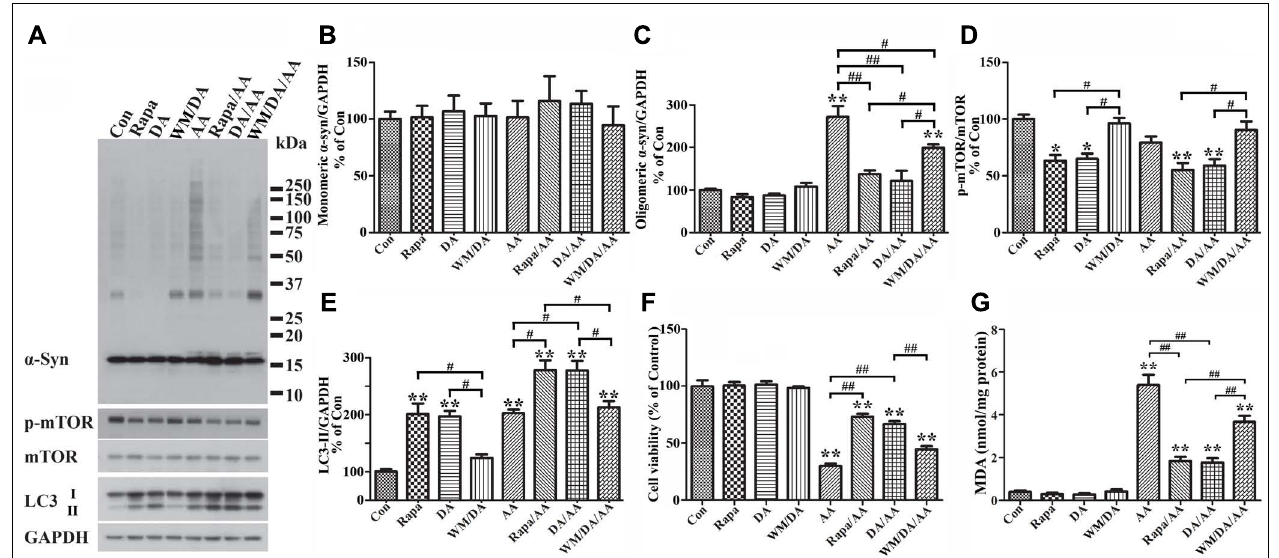
FIGURE 6 | Protection of cells fromAA-elicited α -syn accumulation, LPO, and cytotoxicity by autophagy activation. Four sets of 3D5/DAT cells with 8 days of differentiation and α -syn induction were exposed for 60 h to AA, AA plus Rapa, AA plus DA, AA plus DA andWM, and regarded as AA, Rapa/AA, DA/AA, andWM/DA/AA, respectively. Additional four sibling cultures were similarly treated but without AA and named as Con, Rapa, DA, andWM/DA. Cells harvested from each subset were split into two parts for western blotting and LPO assay. Duplicate cultures were included for cell viability assessment. (A) Western blotting of lysates of all samples with antibodies to α -syn, phosphorylated mTOR (p-mTOR), total mTOR, LC3, and GAPDH. (B–E) Bar graphs summarized quantitative analysis of immunoreactivities displayed in (A) with GAPDH normalization as well in western blot from additional experiments. Results demonstrated that DA or Rapa treatment